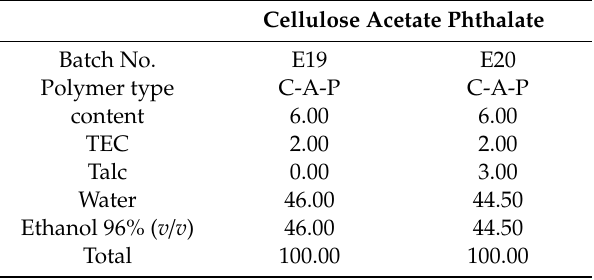
Table 5. Composition of C-A-P coating dispersion. All concentrations are given in percent ( w / w